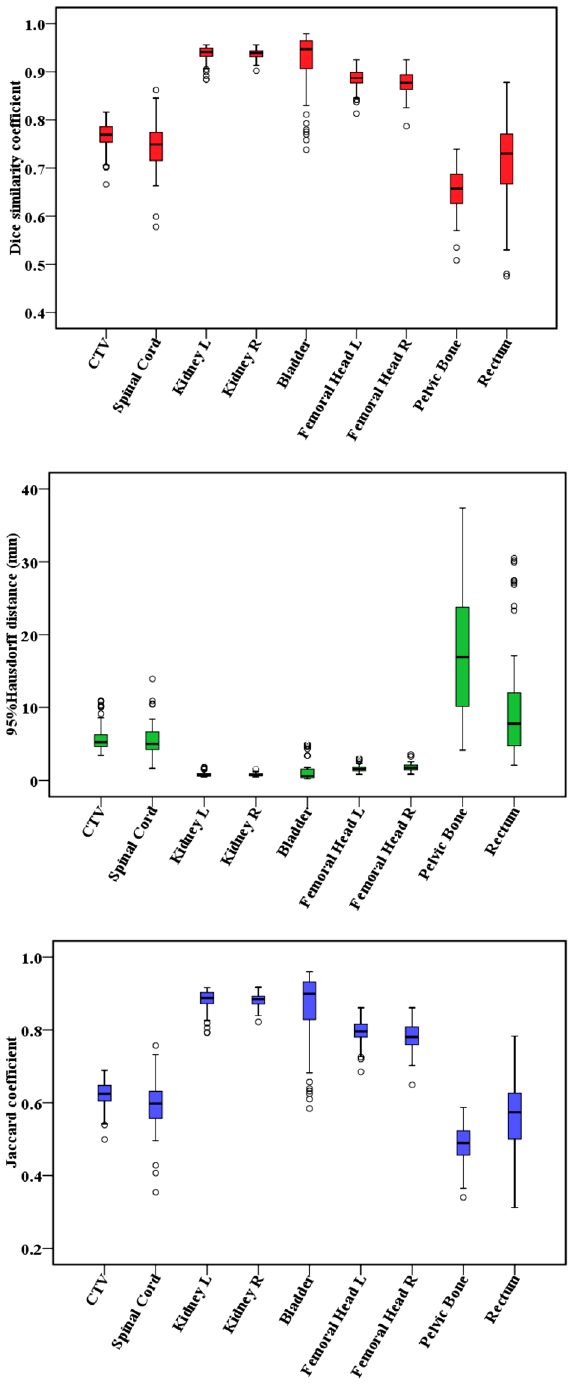
Figure 3. DSC, 95%HD and JC box plot from comparing DL based auto-segmented contours to standard contours for CTV and